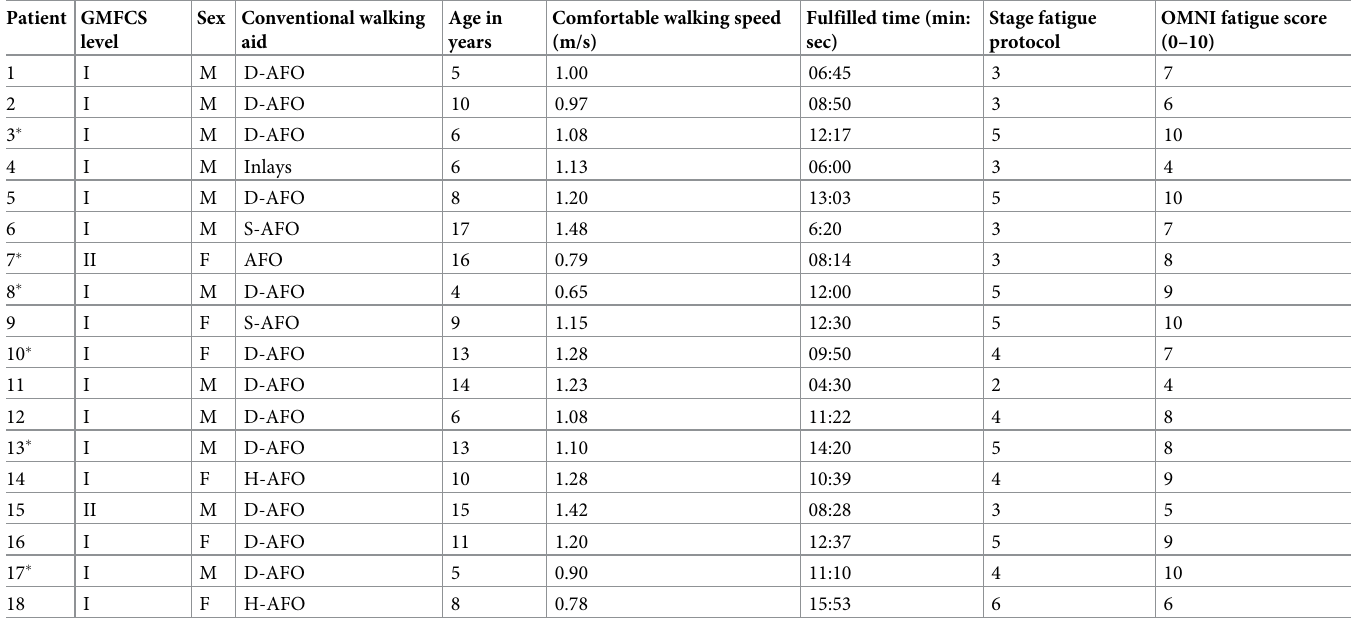
Table 2. Patient characteristics and results of the fatigue protocol.